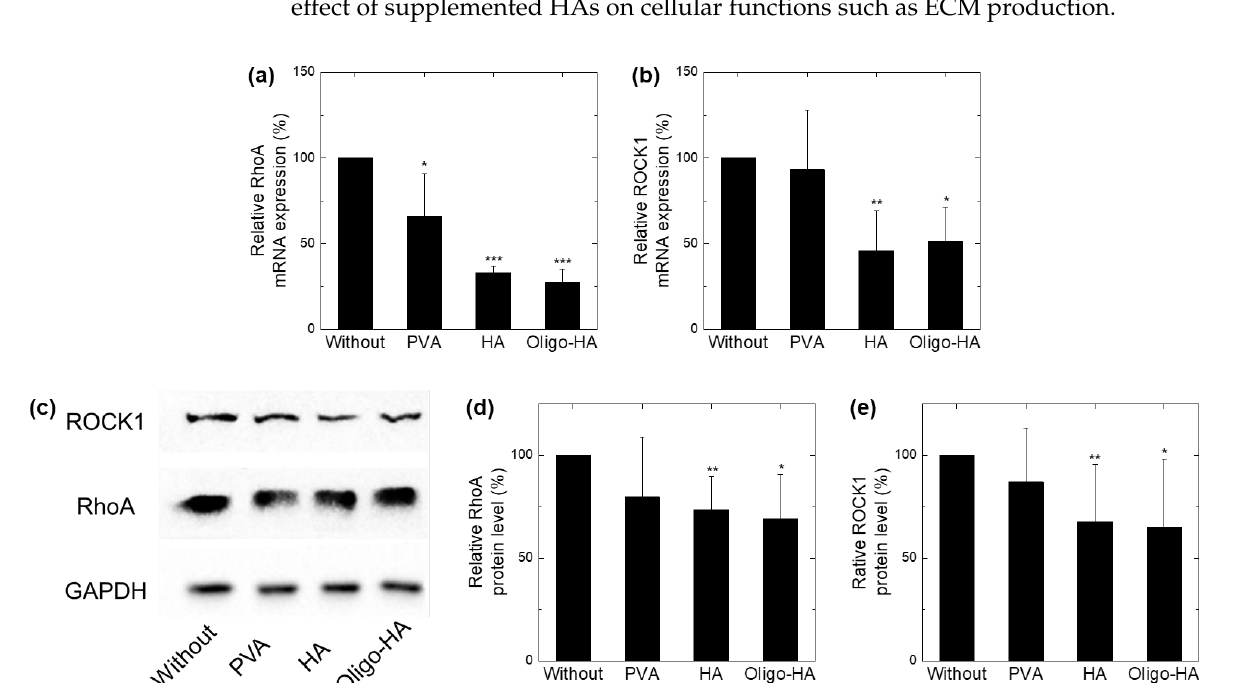
Figure 3. Ras homolog family member A ( RhoA )/Rho-associated protein kinase ( ROCK ) pathway regulation effect of polymeric supplements. NIH-3T3 fibroblast cells were treated with PVA (10 mg/mL), HA (10 mg/mL), or oligo-HA (10 mg/mL) for 30 min, and expression levels of RhoA , ROCK1 , and glyceraldehyde 3-phosphate dehydrogenase (GAPDH) were determined by quantitative real-time polymerase chain reaction (qRT-PCR) and Western blotting analysis. ( a , b ) mRNA levels of ( a ) RhoA and (b) ROCK1 determined through qRT-PCR at 30 min after each treatment with polymers. The mRNA levels were normalized with GAPDH. Data represent mean ± S.D (n = 5). ( c ) Representative images showing Western blotting data from four independent experiments. ( d , e ) Bar graphs show Western blot analysis and quantification of ( d ) RhoA and ( e ) ROCK1 protein levels. * p < 0.05, ** p < 0.01, *** p < 0.001 vs. without.